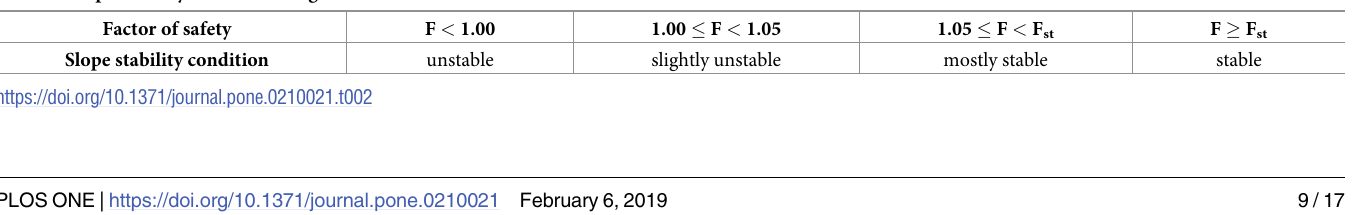
Table 2. Slope stability condition